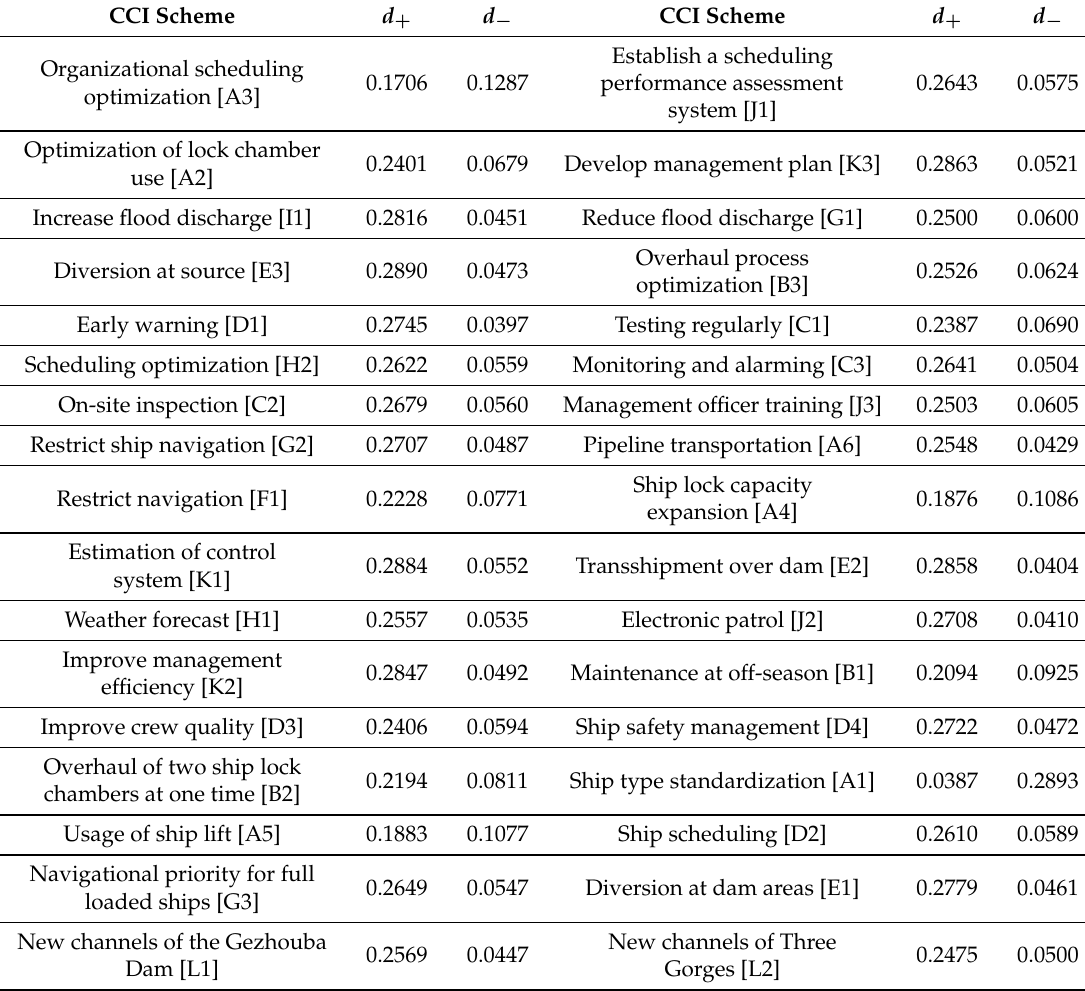
Table 11. Performance of CCI schemes of different